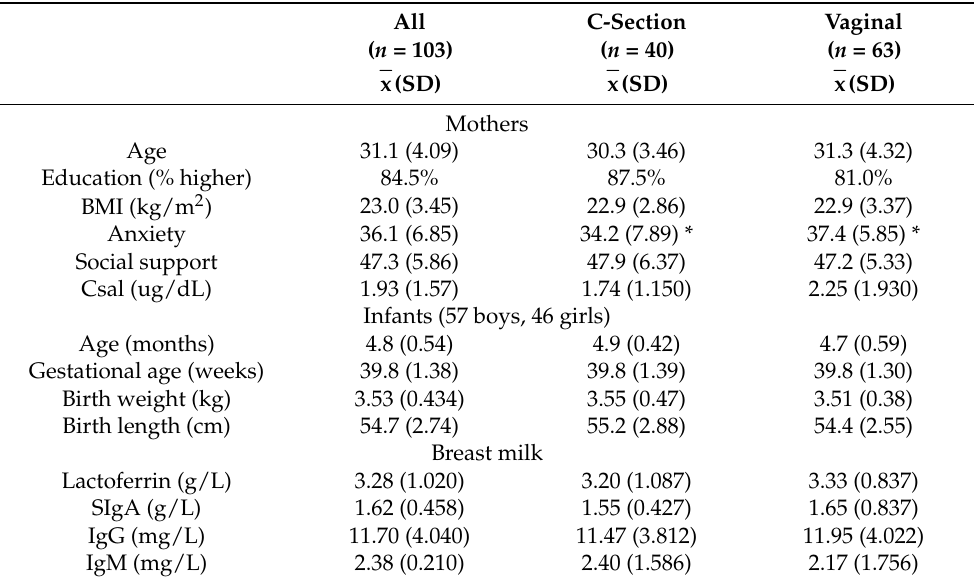
Table 1. General characteristics of all study participants and differences in general characteristics between women delivering vaginally and via